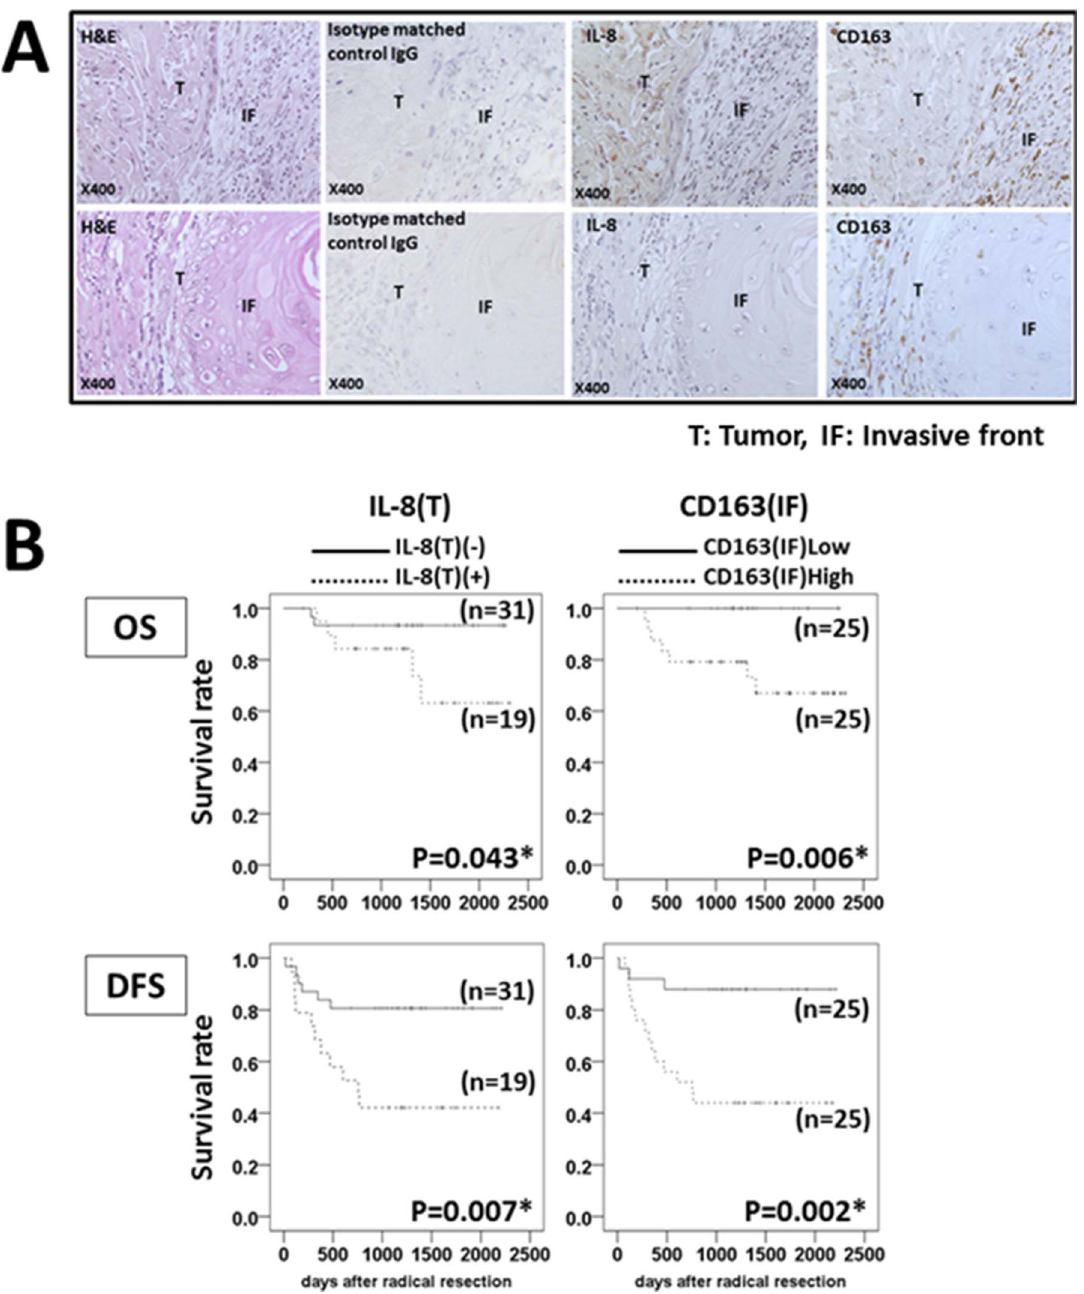
Figure 2. Relationship between IL-8 expression, CD163-positive cell-infiltration in tumor tissues and clinical outcome of OSCC patients. (A) Immunohistochemical staining for IL-8 and CD163. Most of the IL-8-positive cells were tumor cells, not stromal cells in tumor tissues. CD163-positive cells had infiltrated into the tumor invasive front but not the intra-tumor region. (B) Differences in IL-8(T)( + ) vs. IL-8(T)( 2 ) and CD163(IF)High vs. CD163(IF)Low in OS and DFS in OSCC patients, calculated by log-rank test. * P ,